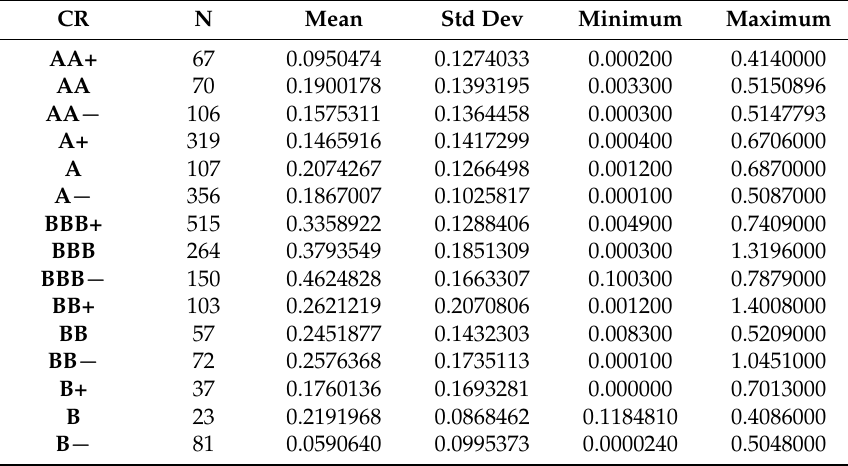
Table 3. Sample Statistic summary- CR and